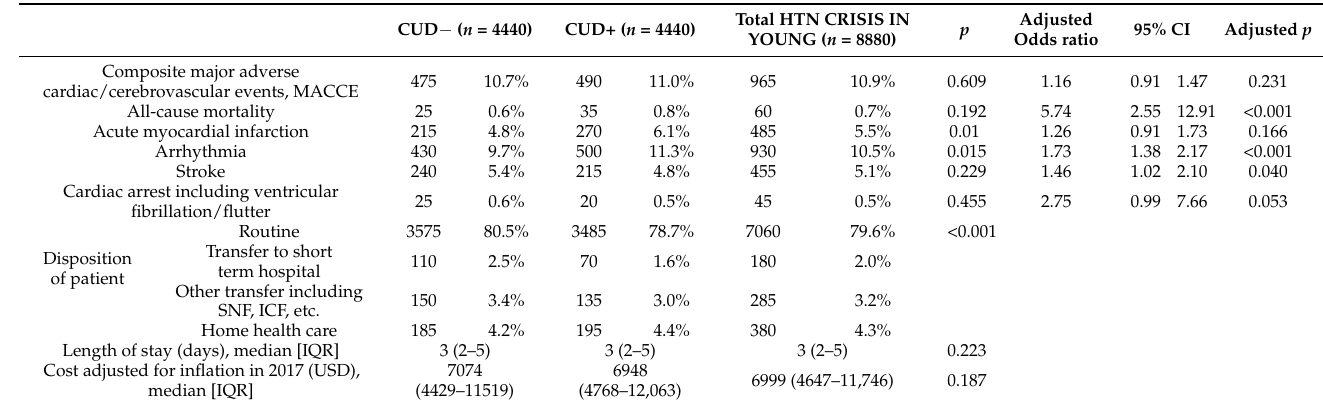
Table 4. In-hospital Outcomes of Hospitalizations for Hypertensive Crisis in Young Adults with vs. without Cannabis Use